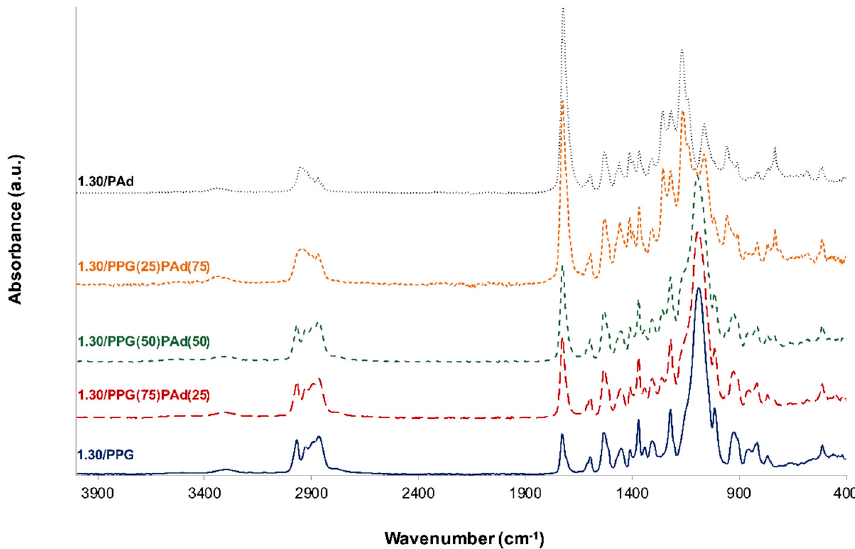
Figure 3. ATR-IR spectra of the TPUs synthesized with PPG, PAd and PPG+PAd blends. The degree of micro-phase separation of the TPUs can be estimated by curve fitting of the carbonyl stretching region at 1800–1650 cm − 1 of the ATR-IR spectra. The assignment of the different C=O species was carried out according to previous studies [18,23,47].